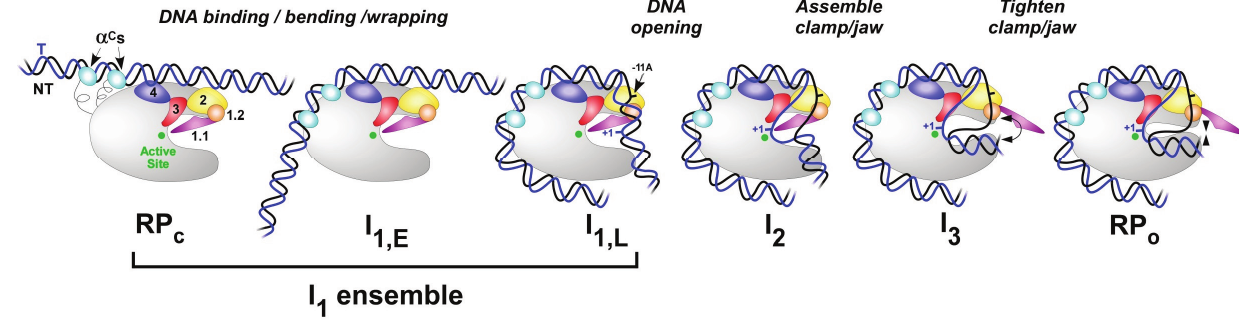
Figure 3. Schematic representation of proposed intermediates in open complex formation and dissociation at (cid:7)P R promoter. Closed complexes like RP C , I 1,E (early), or I 1,L (late) can be significant members of the rapidly equilibrating I 1 ensemble. The (cid:4)CTDs are shown in cyan; other colors are the same as in Figure